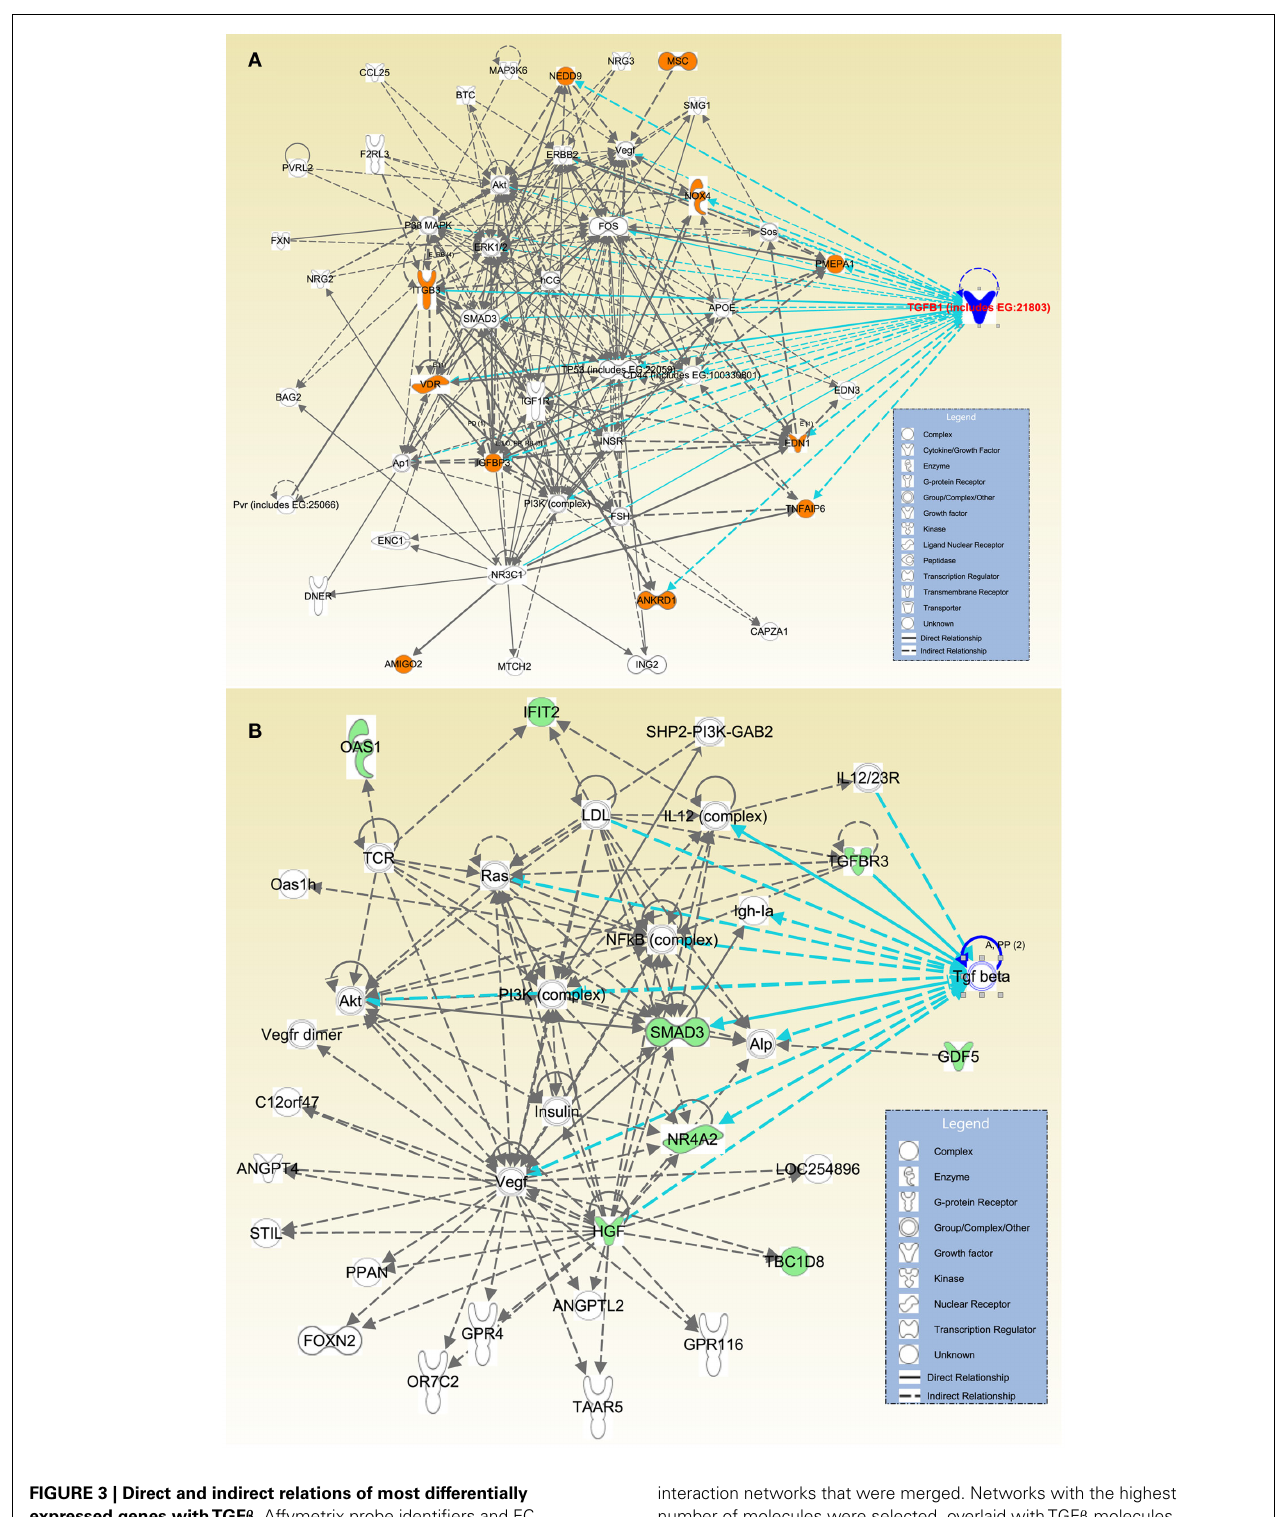
FIGURE 3 | Direct and indirect relations of most differentially expressed genes withTGF β . Affymetrix probe identifiers and FC values of significantly altered transcripts ( n = 27) were uploaded to IPA and each identifier was mapped to its corresponding gene object in the IKB. Interactions were then queried between these gene objects and all other gene objects stored within IPA to generate a set of direct